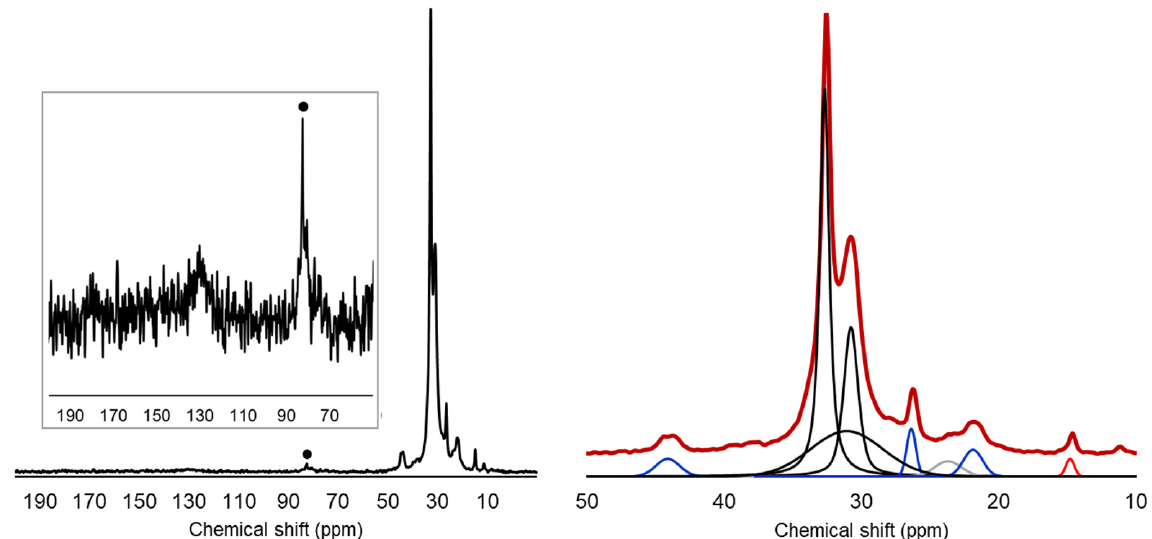
Figure 2. 13 C solid-state NMR spectrum of FIL/S, left, with insert showing a magnification of the aromatic/carbonyl region. On the right, spectral deconvolution of the region containing the main signals of PE and PP. Spinning sidebands are marked by a dot.